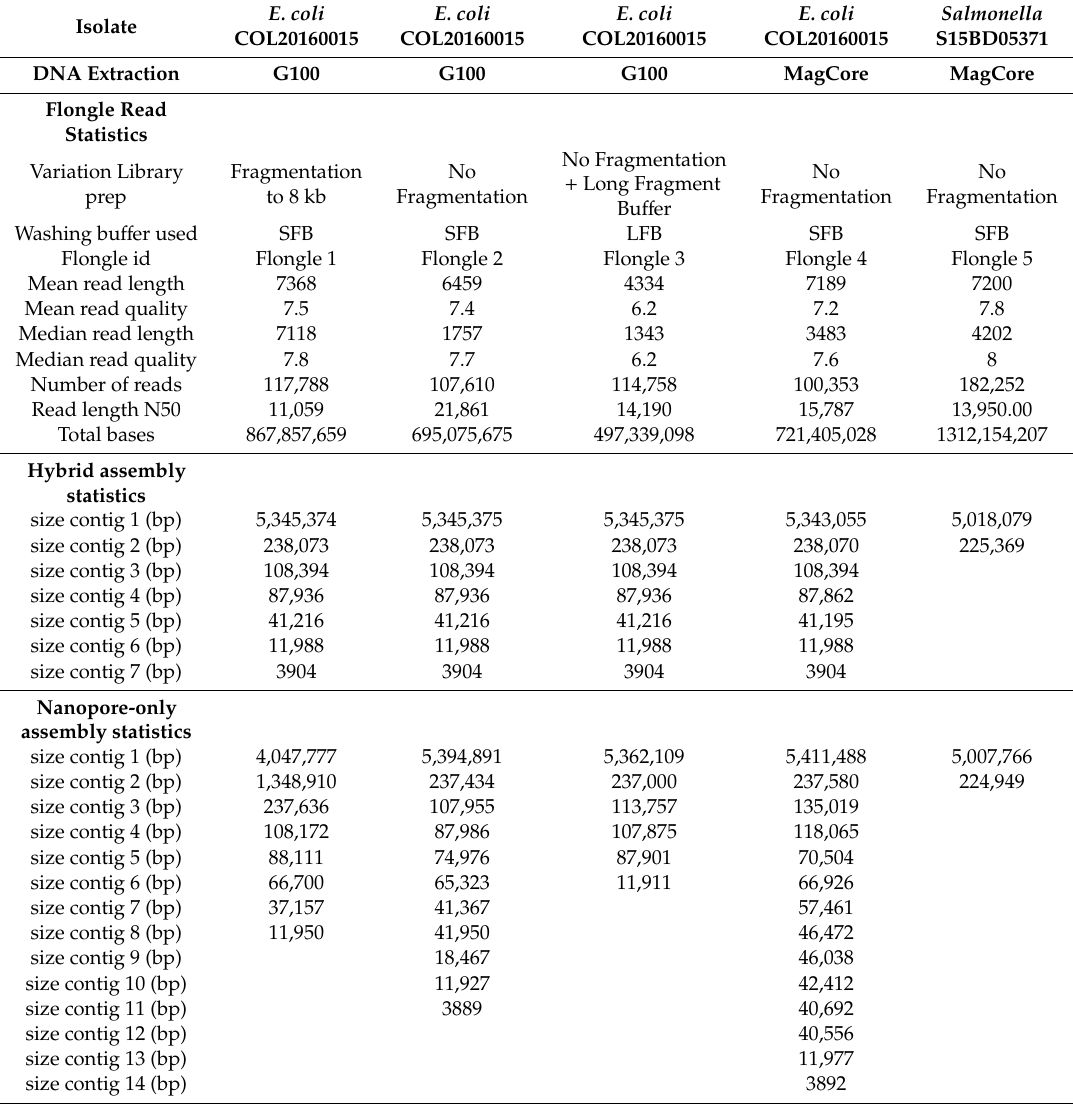
Table 5. Nanopore read and hybrid assembly statistics of Flongle runs (raw reads) with variations in the library